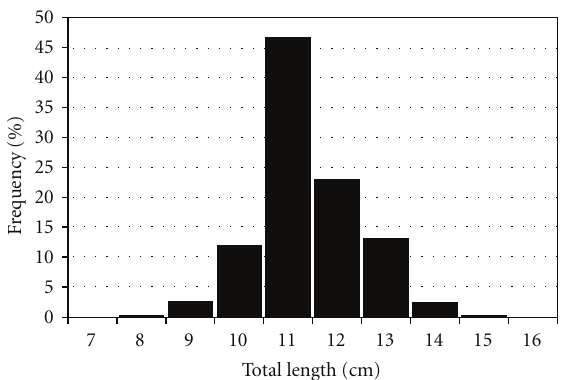
Figure 2: Total length-frequency distribution of Symphodus bail- loni .